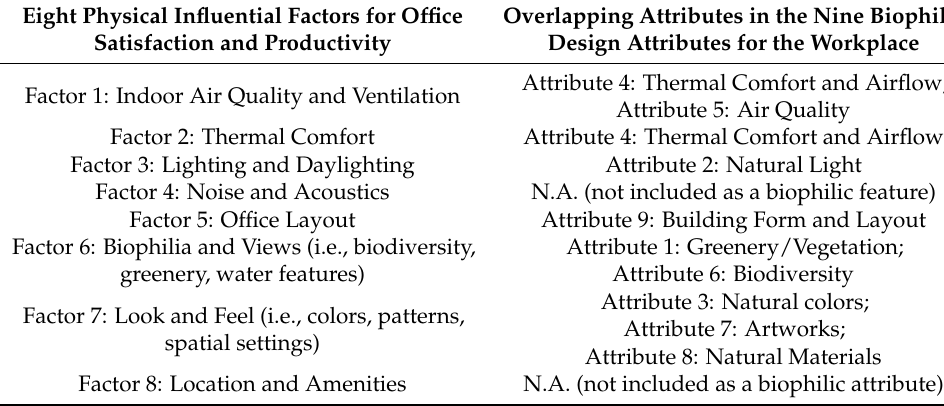
Table 2. Overlaps between eight physical influential factors for office satisfaction and productivity, and the nine biophilic design attributes for the